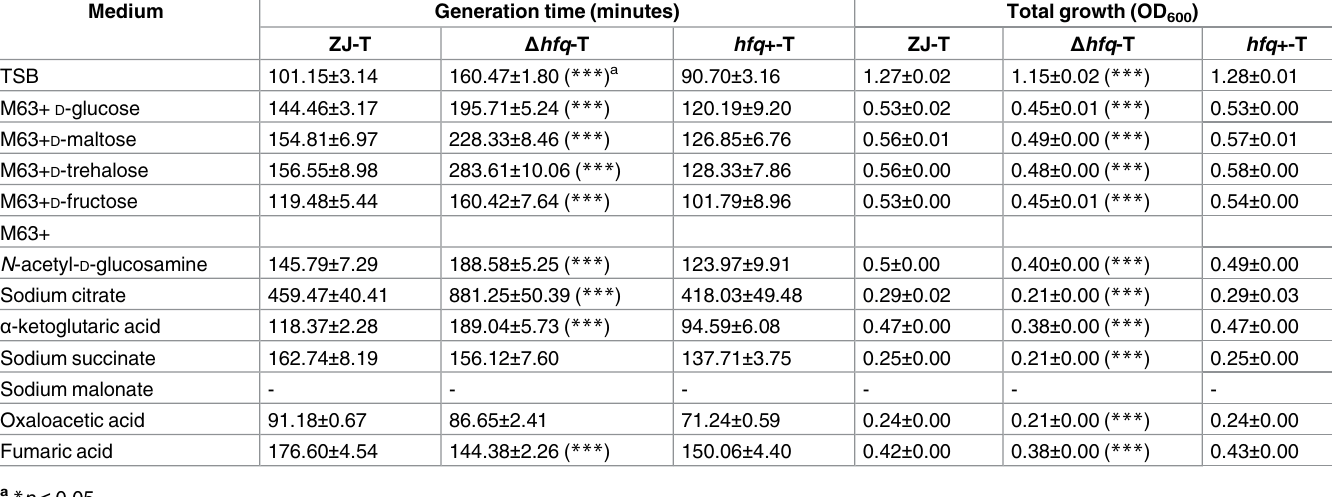
Table 2. Effect of hfq deletion on growth rate and total growth in rich medium and minimal medium M63 supplemented with various carbon sources. Values correspondto the mean of three independent cultures. Significant statistical differences between strains and WT are indicated( * p < 0.05, ** p < 0.01, *** p < 0.001). Growth rates are expressed as generation times.